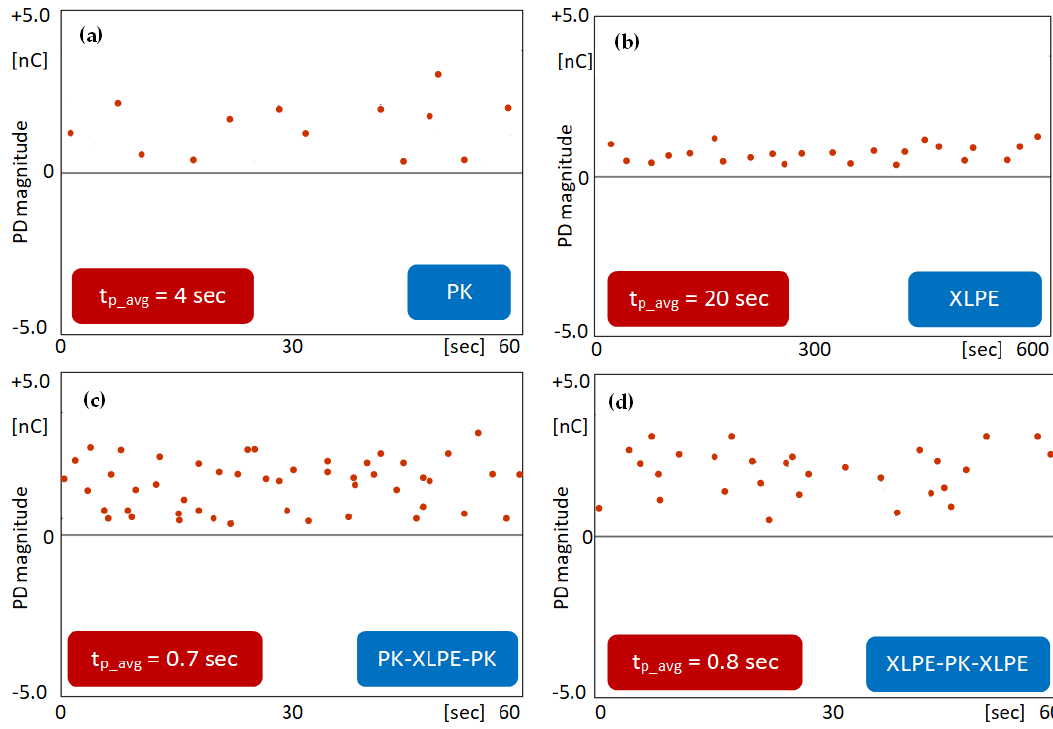
Figure 8. Partial discharges patterns at 20 kV DC voltage for specimens: ( a ) PK, ( b ) XLPE, ( c ) PK-XLPE-PK, ( d ) XLPE-PK-XLPE.